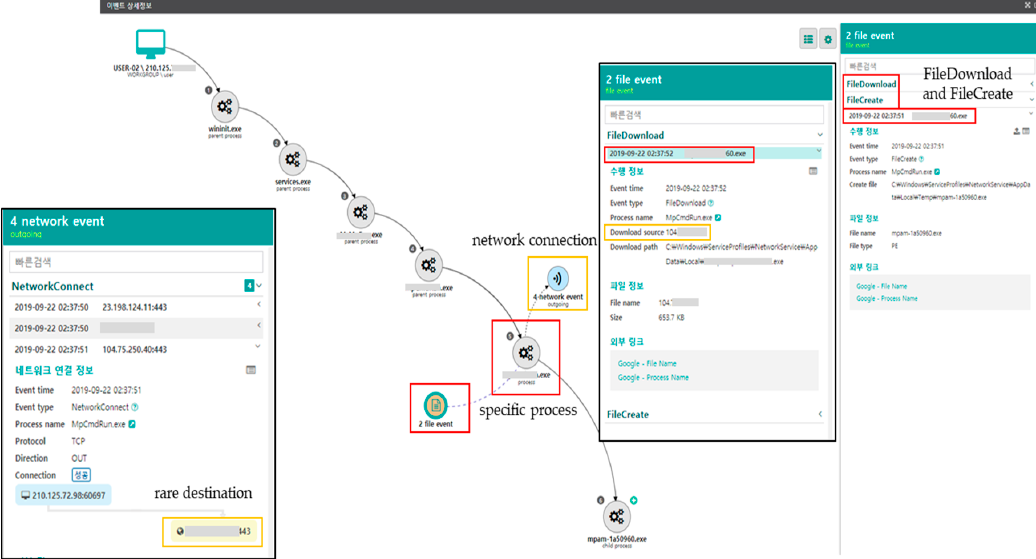
Figure A1. Attack Profile Scenarios for suspected malware download.